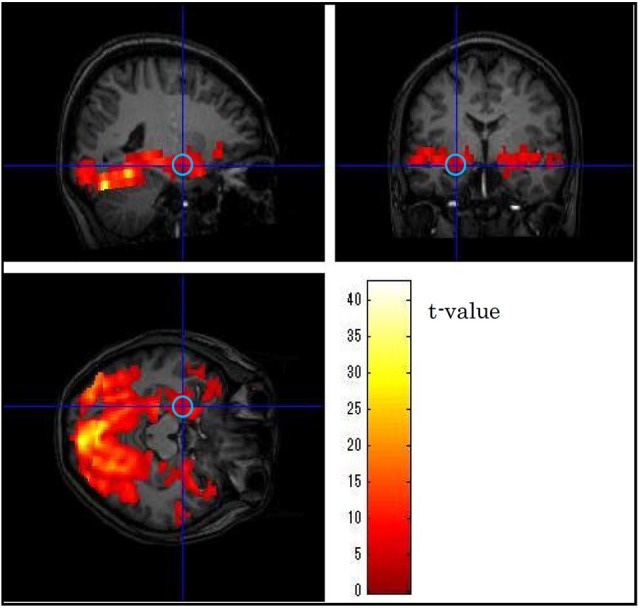
Example of the position of a volume of interest (left amygdala) in one subject. The central position was determined using as guides neuroanatomical atlases and three-dimensional activation maps.